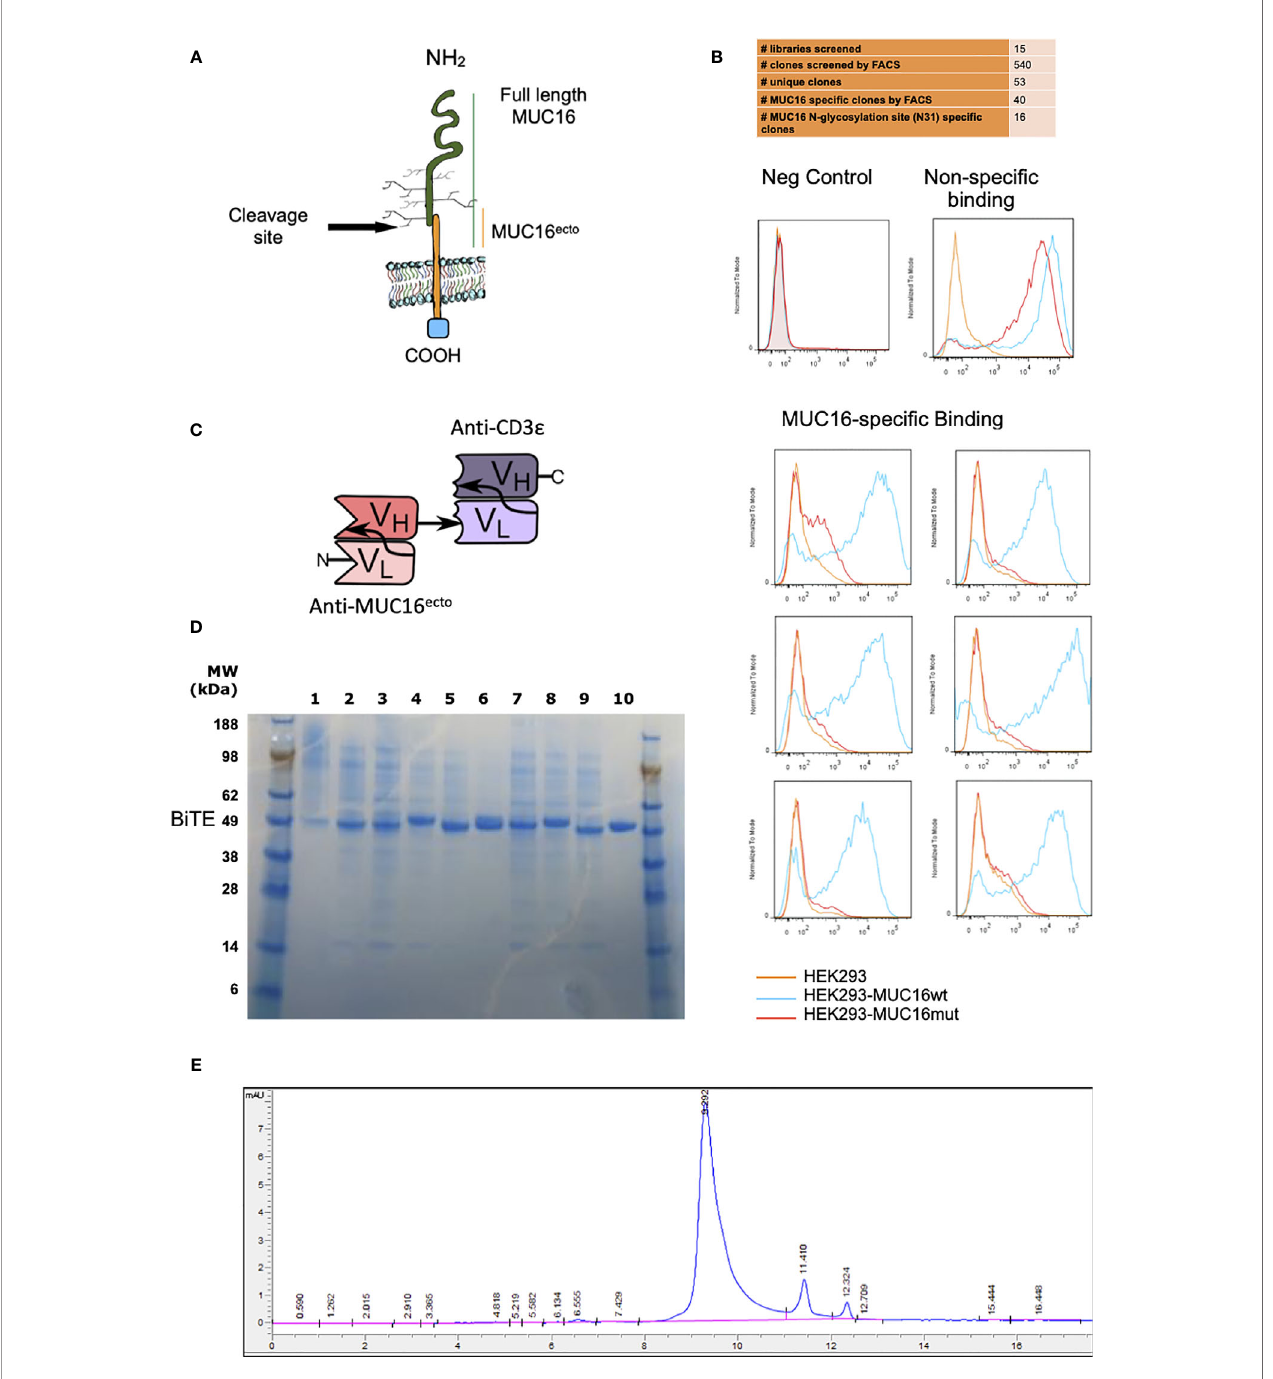
FIGURE 1 | Screening and identi fi cation of human MUC16 ecto speci fi c antibodies. (A) Schematic representation of MUC16 antigen and the c114 retained ectodomain (MUC16 ecto ) which serves as the antibody target. (B) Phage display binding analysis by FACS. Only targets that bind to MUC16 ecto (blue) and not the mutant MUC16 (orange) were selected for sequencing and further development. Examples of negative control (top left) and non-speci fi c binding (top right) are shown. (C) Schematic representation of MUC16 ecto BiTE con fi guration. (D) Purity of CD3 ϵ -congugated MUC16 ecto -speci fi c BiTEDs were validated by SDS-PAGE. Expected band size 50-55 KDa. (E) MUC16 ecto -BiTEDs purity and structural integrity evaluated by SE-HPLC. The SE-HPLC analysis demonstrates the correct apparent molecular weight with the majority of the protein in monomeric